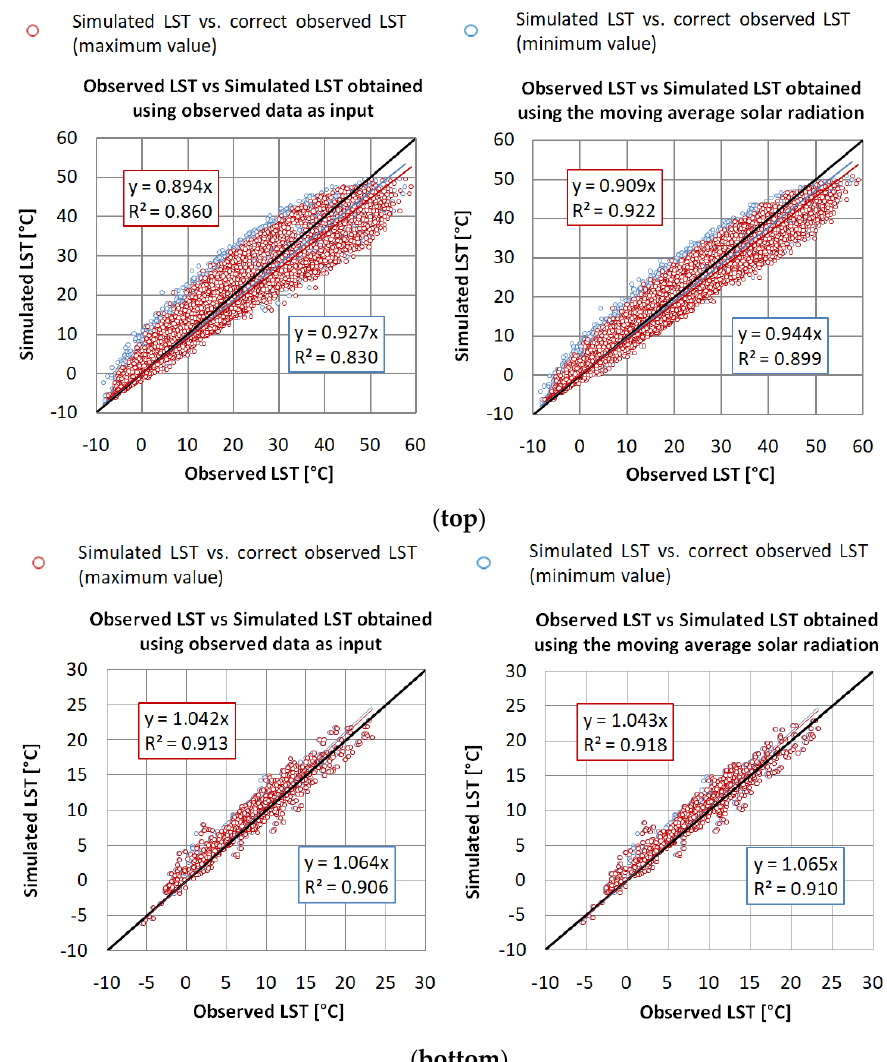
Figure 3. Scatterplot between observed vs. simulated Land Surface Temperature (LST) over the “Ponte Olona” station point during clear sky days ( top ). Scatterplot between observed vs. simulated LST over the “Ponte Olona” station point during cloudy days ( bottom ).